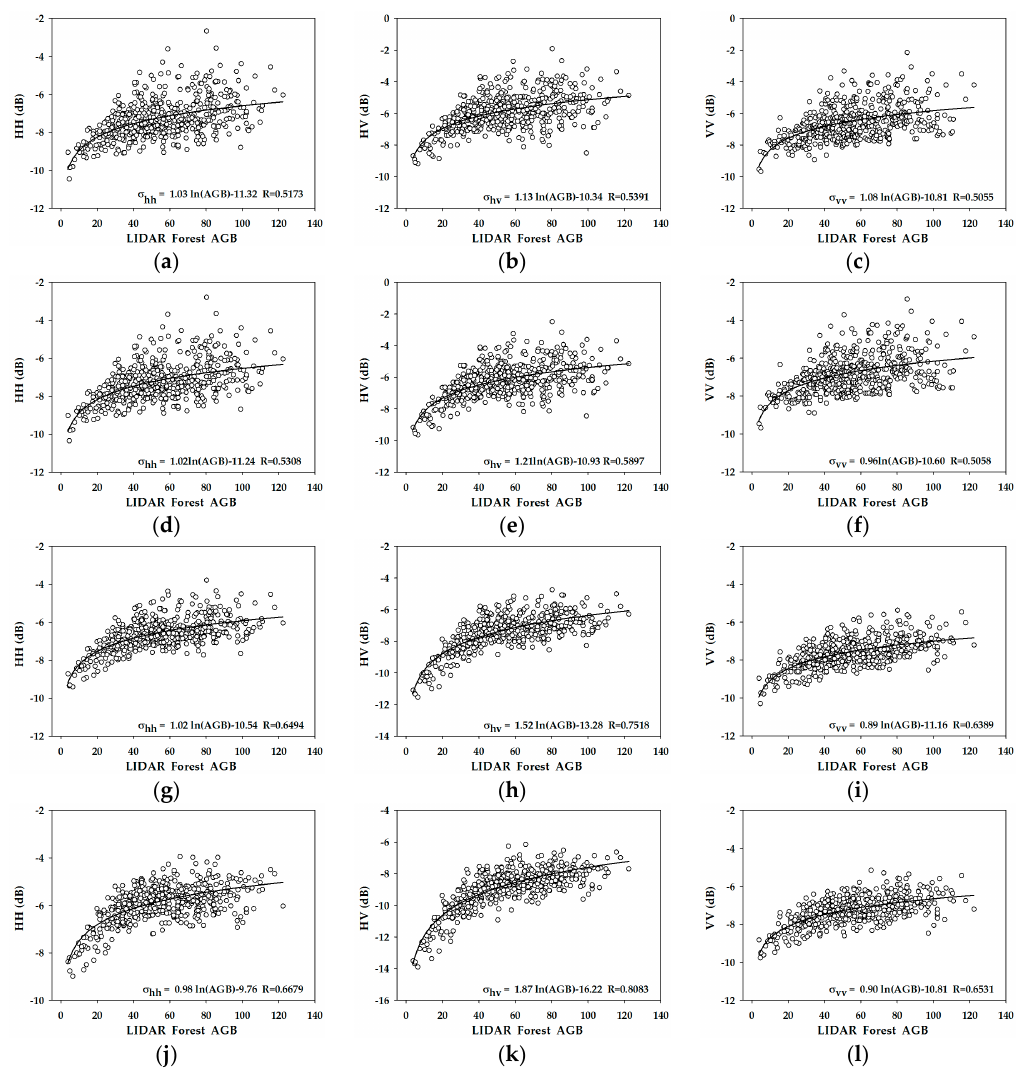
Figure 21. Correlation between backscattering coefficients of different correction steps and LiDAR-derived forest AGB. ( a ) GTC HH; ( b ) GTC HV; ( c ) GTC VV; ( d ) POA HH; ( e ) POA HV; ( f ) POA VV; ( g ) POA + ESA HH; ( h ) POA + ESA HV; ( i ) POA + ESA VV; ( j ) POA + ESA + AVE HH; ( k ) POA + ESA +AVE HV; ( l ) POA + ESA + AVE VV.